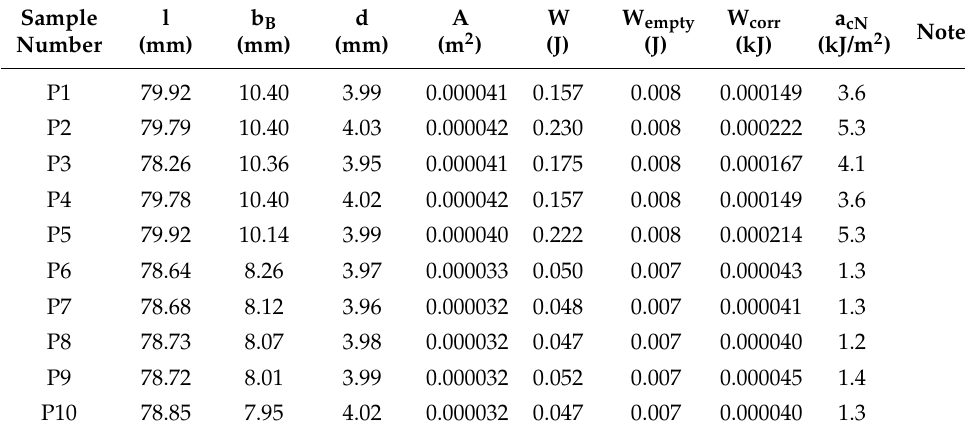
Table A16. Results of the notched impact tests and unnotched impact tests of P_C,PS. Sample